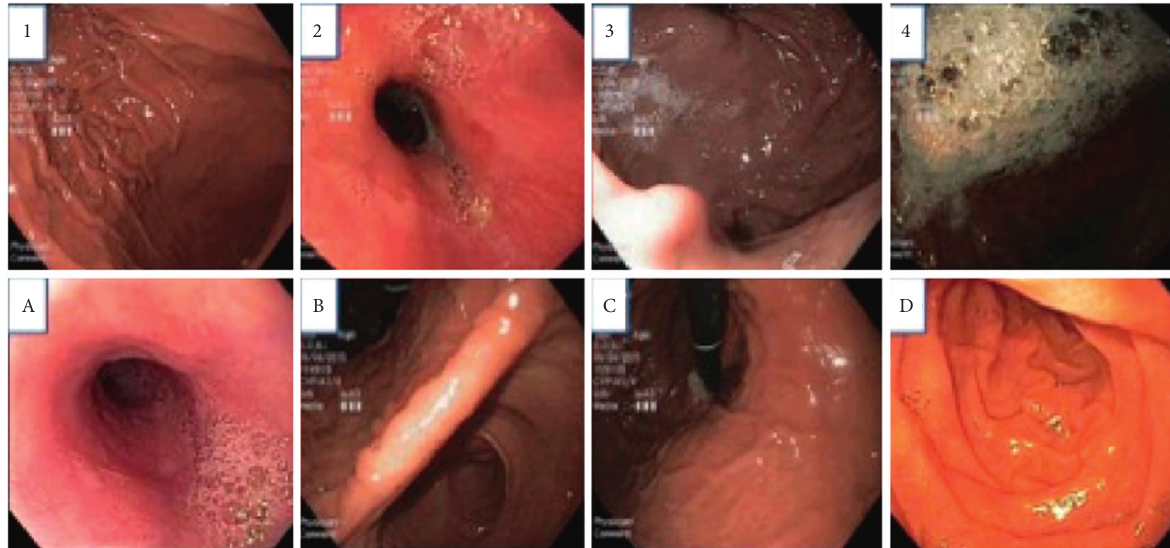
Figure 9: Endoscopic scoring system. Score of 1: No bubbles; Score of 2: Minimal bubbles which the endoscopist must actively look for; Score of 3: Foam is obviously present but not severe; Score of 4: Severe foam obscuring vision; Area (A): Esophagus; Area (B): The antrum and angularis of the stomach; Area (C): The body and fundus of the stomach; Area (D): Duodenum. TMVS is the sum of the scores of areas A, B, C, and D added together. TMVS: total mucosal visibility